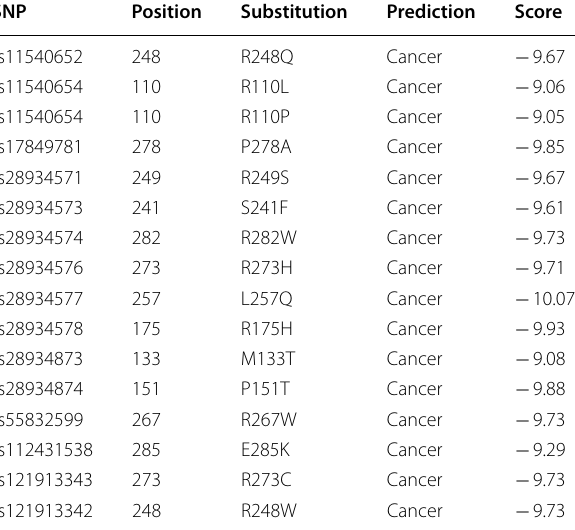
Table 3 Cancer-associated SNP where the threshold value is 0.75. Scores having − association with